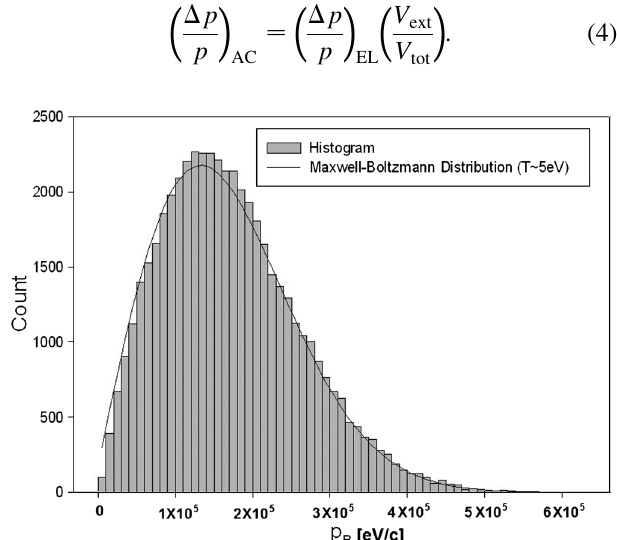
FIG. 24. Flowchart of the simulation procedure.